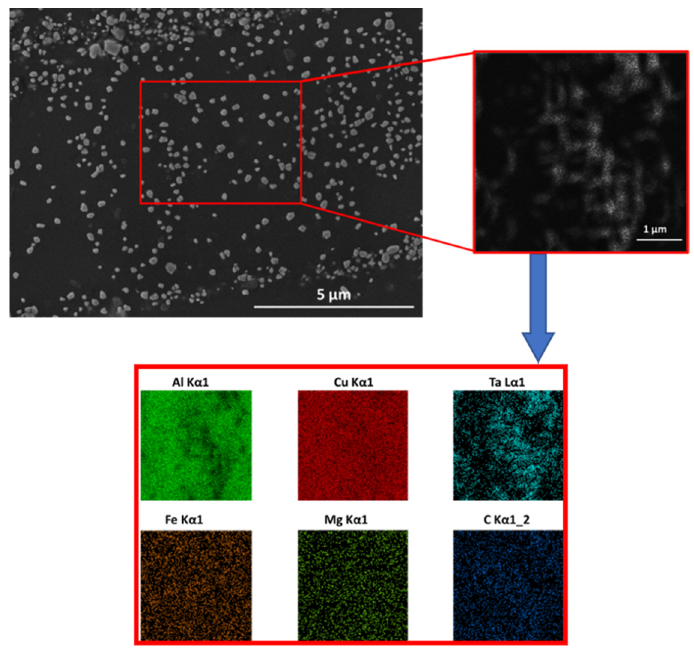
Figure 7. SEM and EDS mapping images of triple additive hybrid composite.